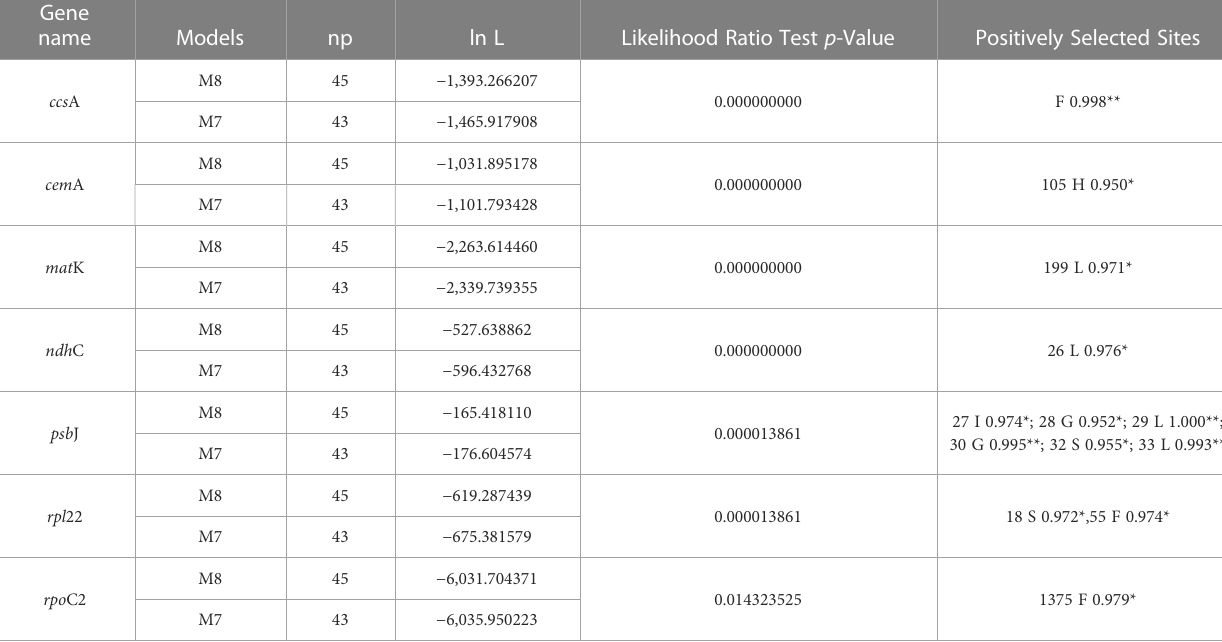
TABLE 2 Positively selected genes and sites detected in the plastomes of Phedimus subg. Aizoon